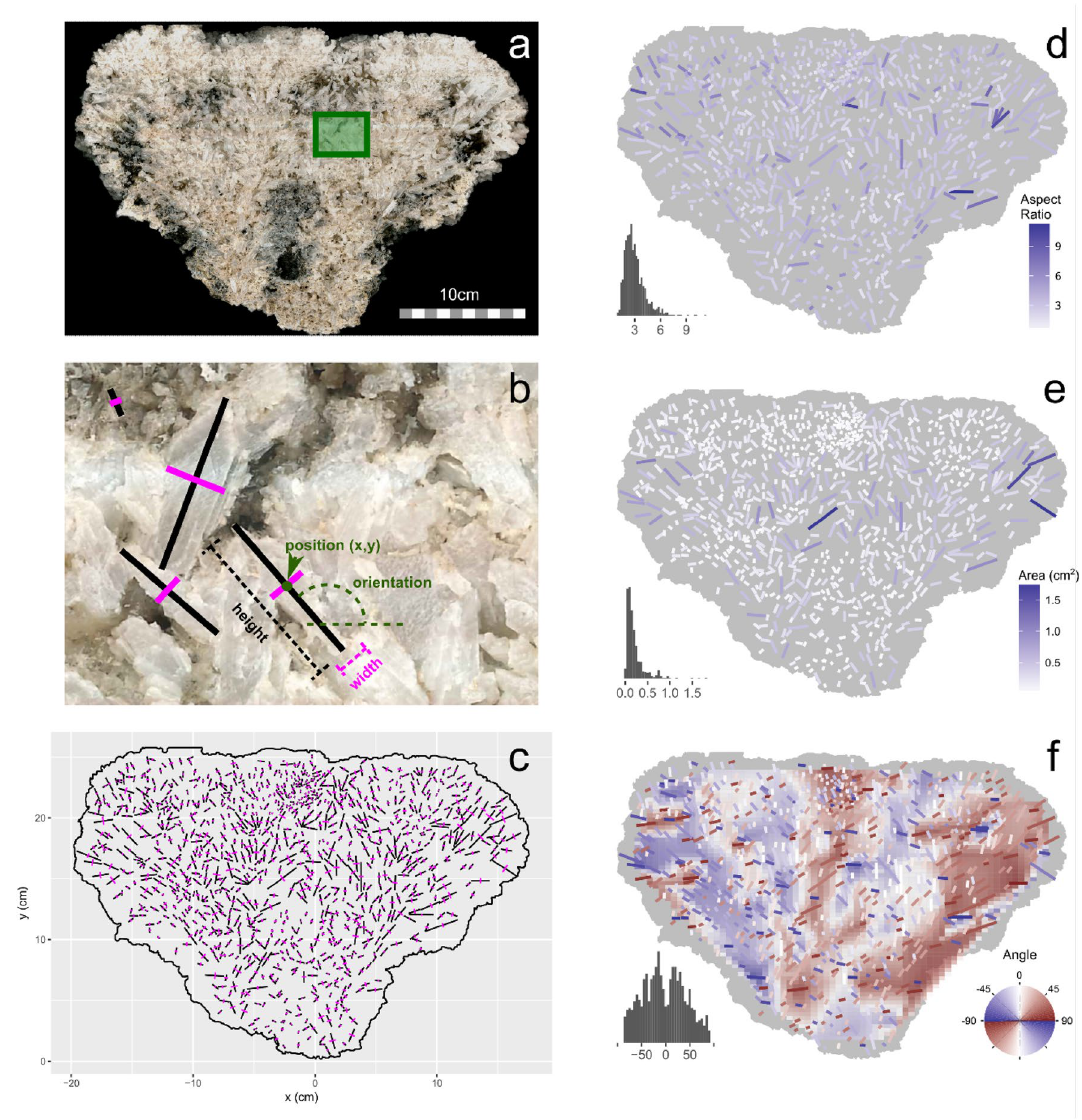
Figure 2. Quantitative characterization of the gypsum crystal distribution within the Gypsum Stromatolite- Like Structure. ( a ) Cross-section of the sample. Dark regions correspond to organic materials and/or large holes. ( b ) Detailed image (green rectangle in panel a ) showing the crystals and the definition of parameters used in this study. ( c ) Long (black) and short (purple) segments of the measured crystals. ( d ) Aspect ratio distribution of the crystals, ( e ) Area distribution (cm 2 ), ( f ) Orientation distribution (degree), the underlying colour map is an interpolation of the individual values. A histogram of the corresponding quantities is in the lower left corner of panels ( d ), ( e ) and ( f